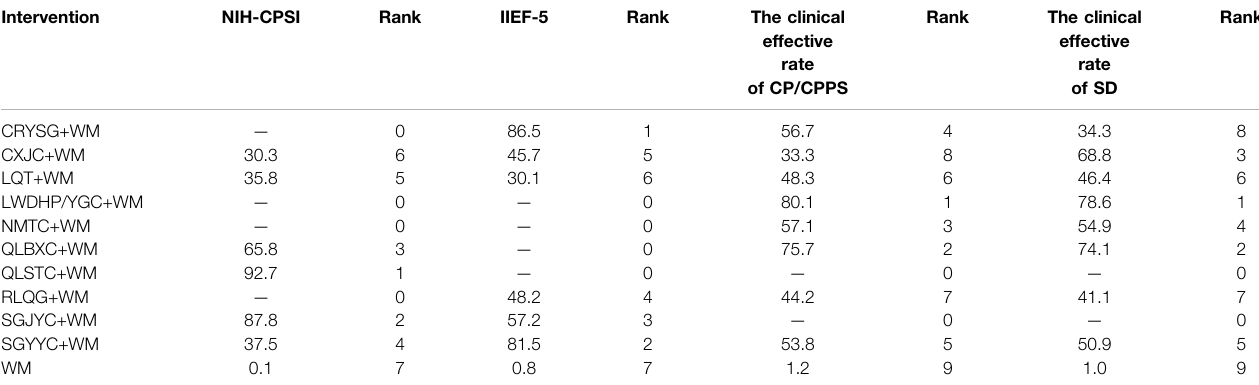
TABLE 3 | Ranking probability for all treatments on NIH-CPSI, IIEF-5, the clinical effective rate of CP/CPPS, the clinical effective rate of SD. Intervention NIH-CPSI Rank IIEF-5 Rank The clinical